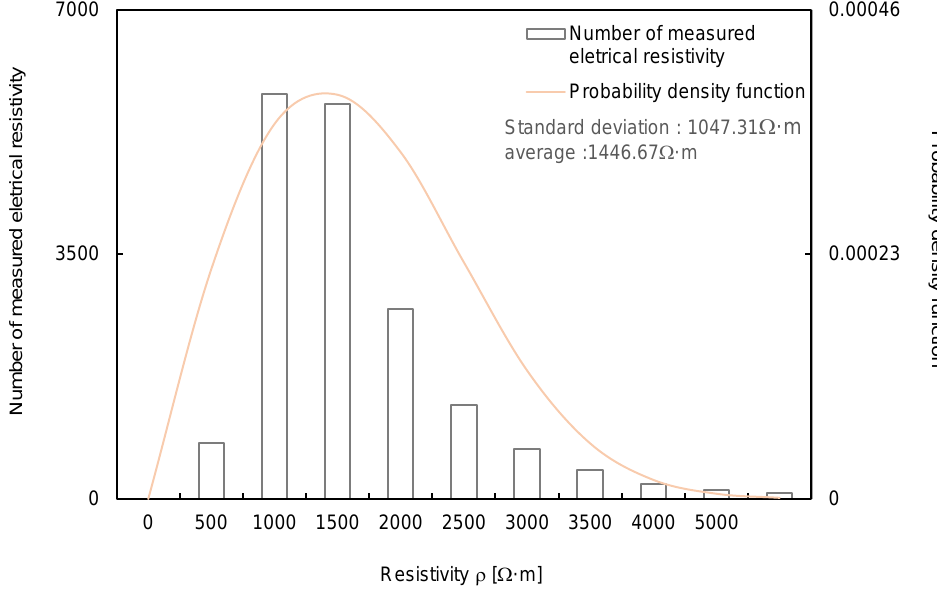
Figure 4. Normal distribution curve of the measured electrical resistivity.